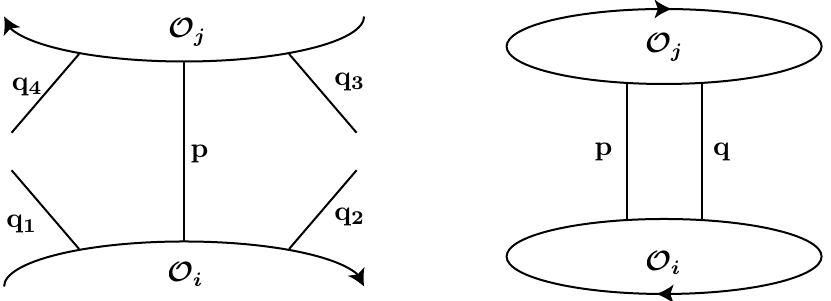
O O i and j . (Right) Example of